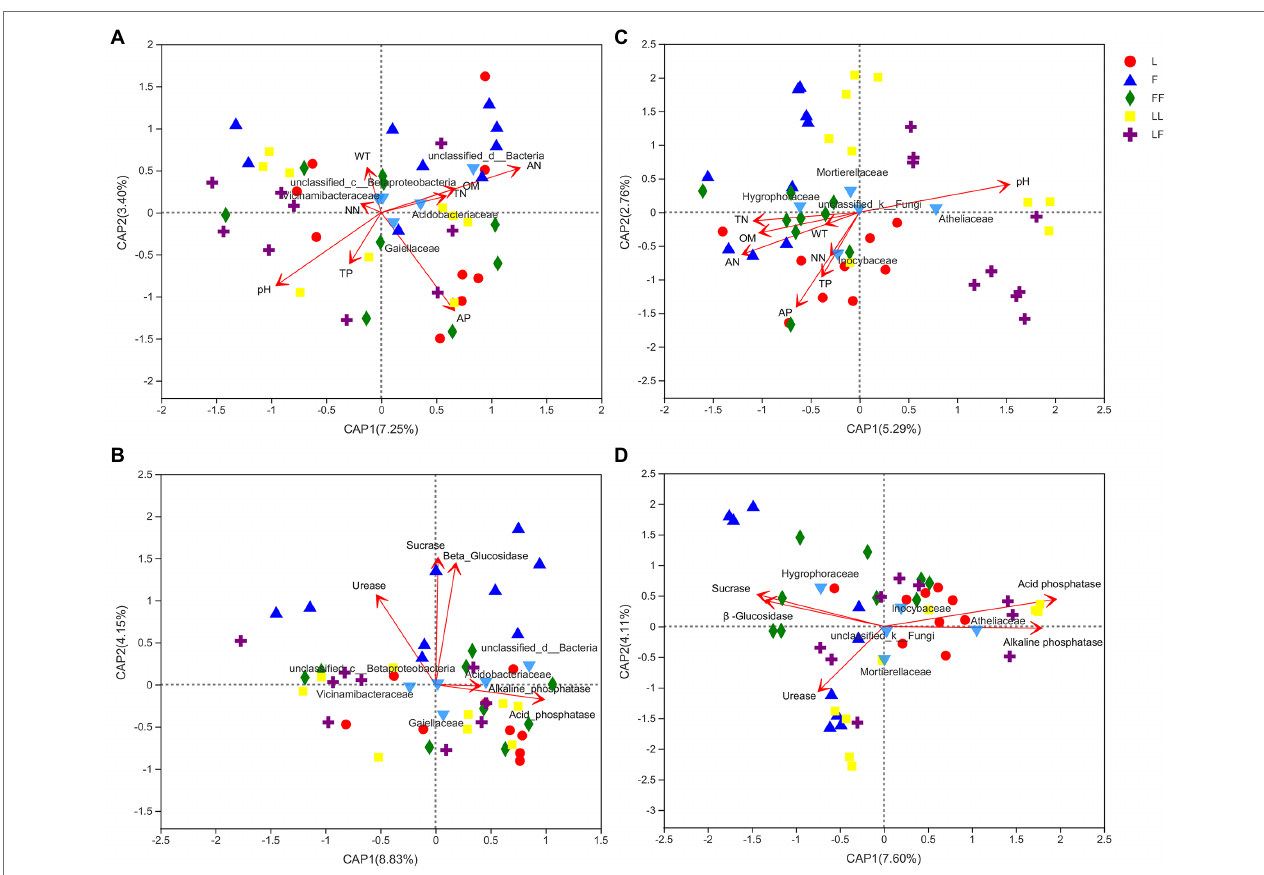
FIGURE 7 | Distance-based redundancy analysis (db-RDA) to show correlation between microbial community and environmental factors in different soil samples. (A) Bacterial families and nutrient; (B) bacterial families and enzymatic activity; (C) fungal families and nutrient; (D) fungal families and enzymatic activity. TN, total nitrogen; AN, ammonium nitrogen; NN, nitrate nitrogen; TP, total phosphorus; AP, available phosphorus; OM, organic matter; WT, water content. Refer to Figure 1 legend for relevant